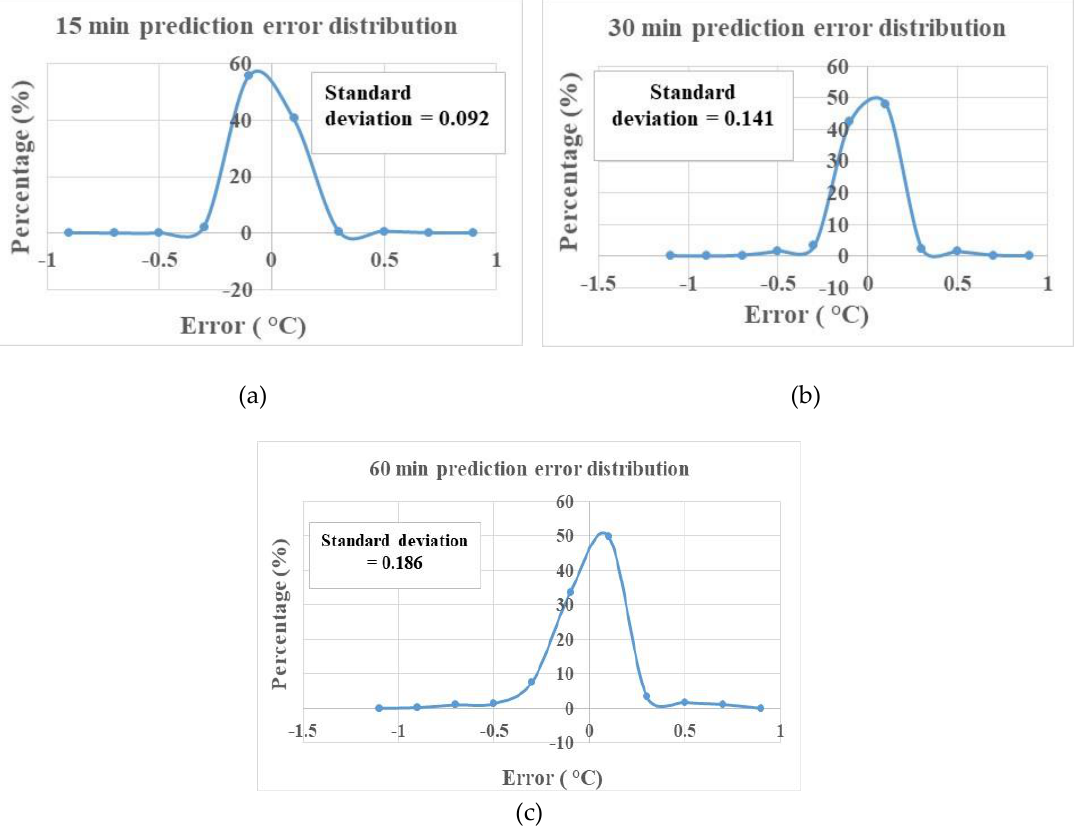
Table 9. Sixty-minute prediction results for experiment B.